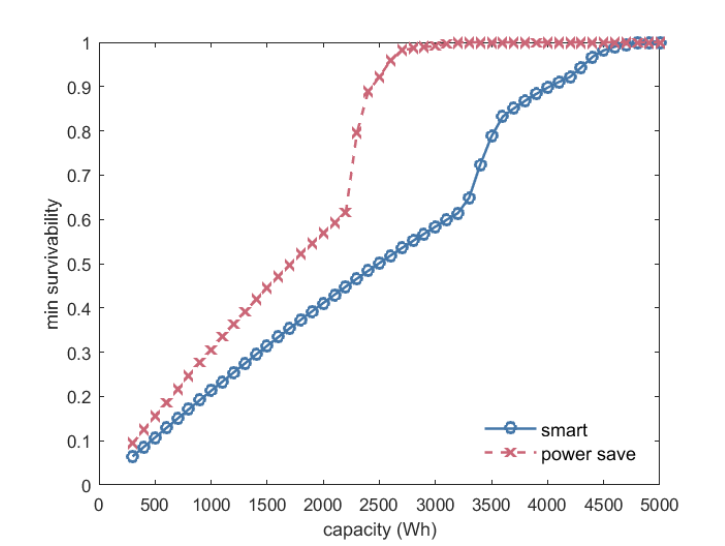
Figure 10. Minimum survivability per year as a function of the battery capacity for the strategies smart and power-save, with a backup capacity of